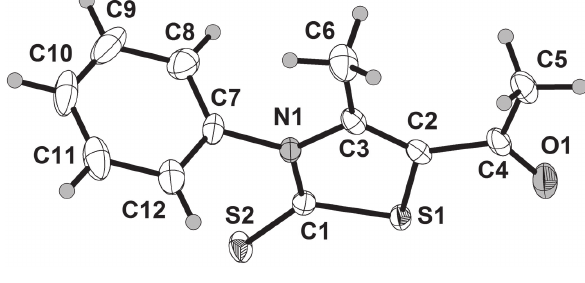
Table 1: Data collection and handling.